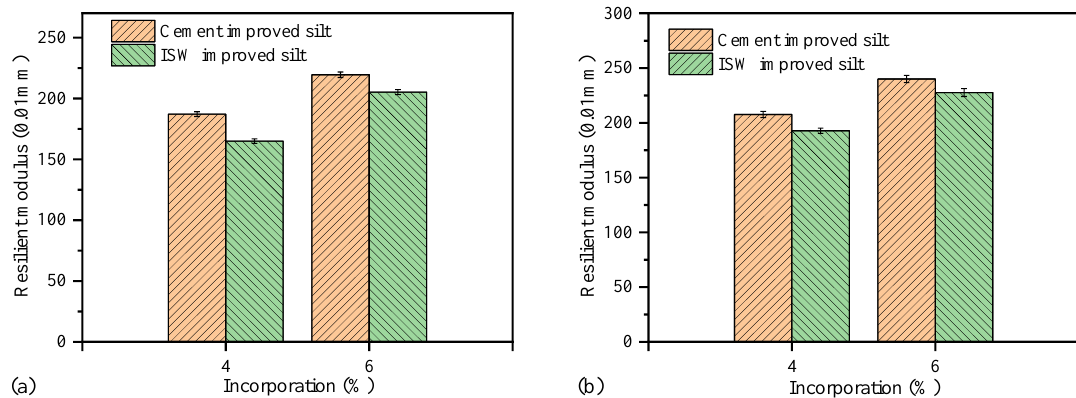
Figure 14. Resilient modulus with ( a ) curing age of 7 days and ( b ) curing age of 28 days. The comparison of the deflection of two kinds of improved silt is shown in Figure 15.